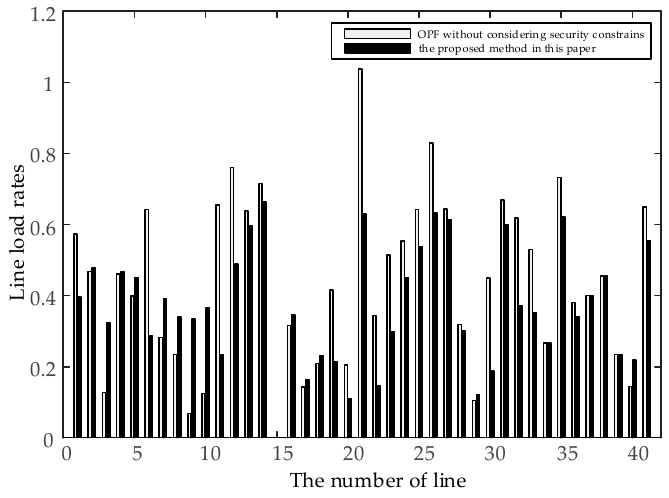
Figure 8. The comparison of line load rate under the failure of lines 4–12.